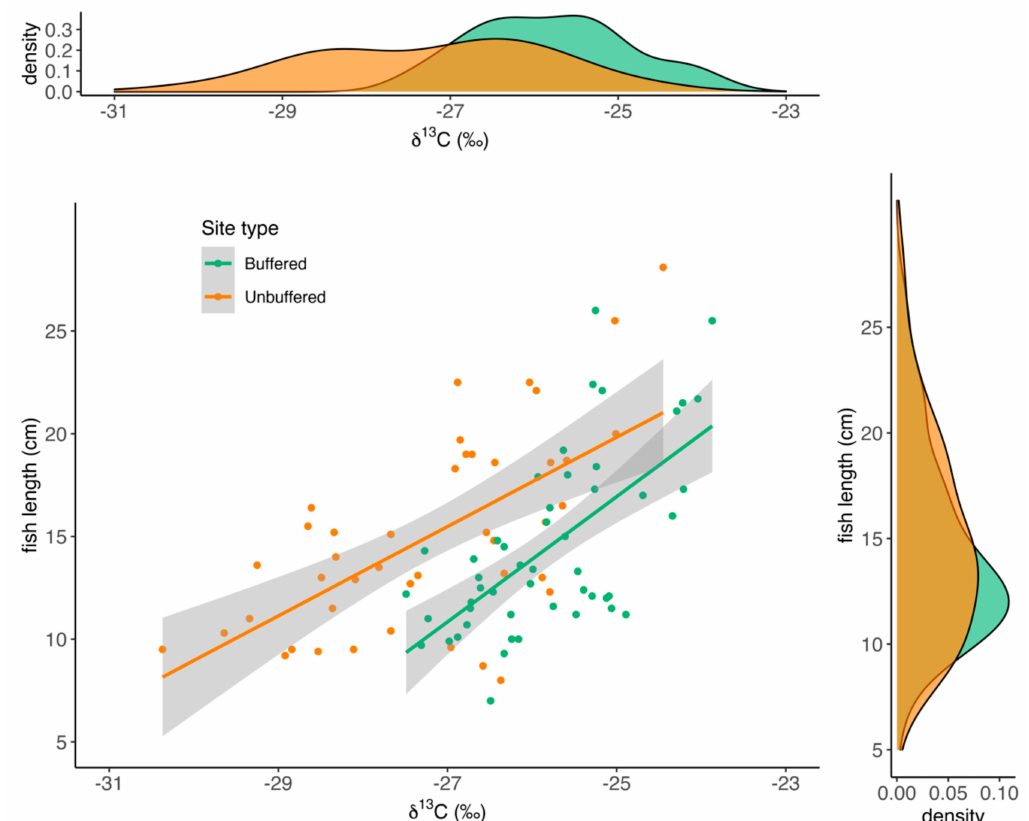
Figure 6. Relationship between isotope signatures ( δ 13 C) and fish body size (cm) whilst accounting for site type (unbuffered and buffered, N = 93 biological samples). Separate regression lines for buffered (green) and unbuffered (orange) sites. The density plots along margins show differences in the distribution of values (top, δ 13 C; right, fish length) between the buffered and unbuffered sites. Table 2. Results from the mixed models testing the influence of riparian buffer on carbon